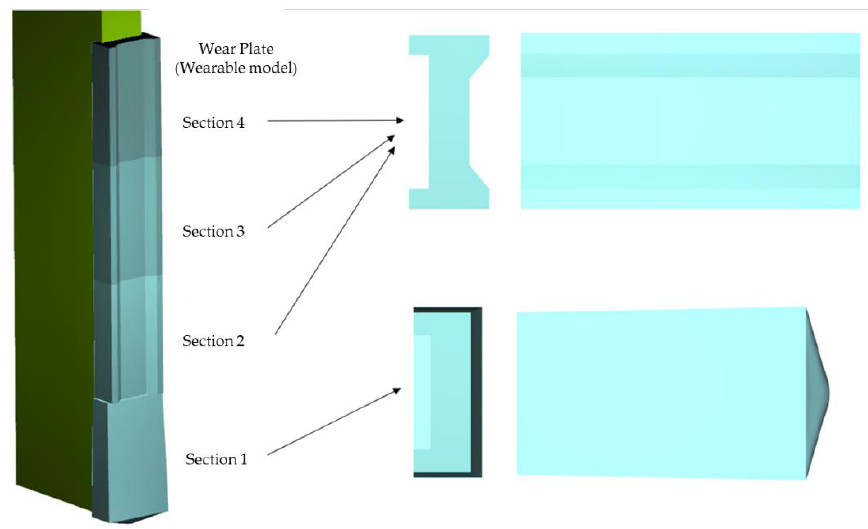
Figure 5. Assembly of each section of the wear plate.